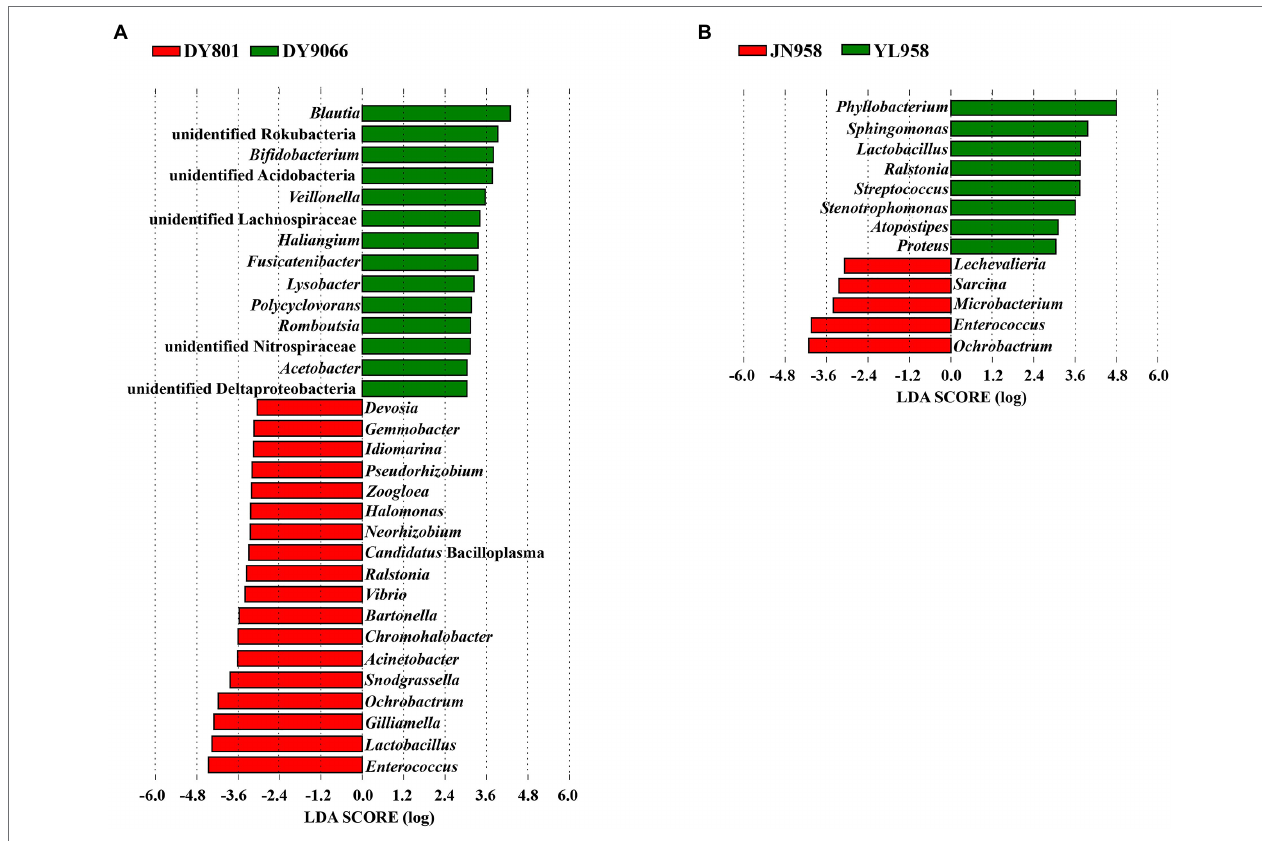
FIGURE 8 | The linear discriminant analysis effect size (LEfSe) analysis of microbial abundance at the genus level. Only the taxa with LDA scores of >3.0 were presented. (A) Analysis of two populations on two maize varieties at a same collection site. (B) Analysis of two populations on a single maize variety at two collection